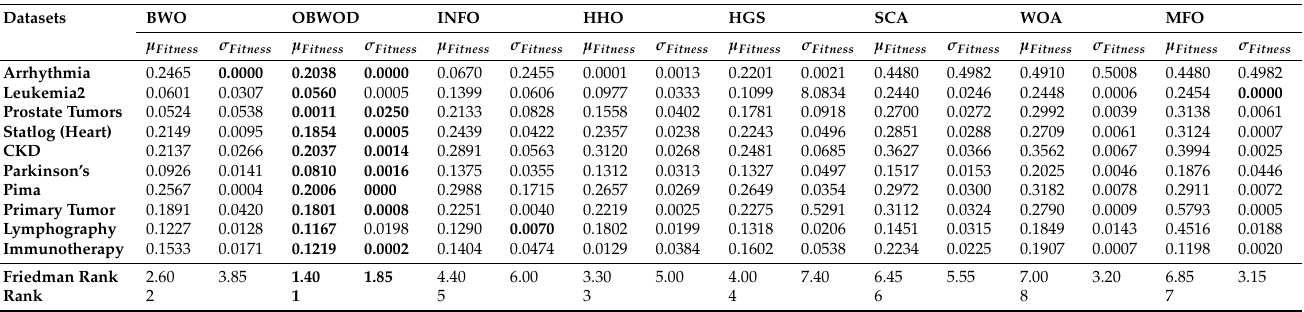
Table 7. Comparison of the best fitness between OBWOD and the other optimization algorithms based on the kNN